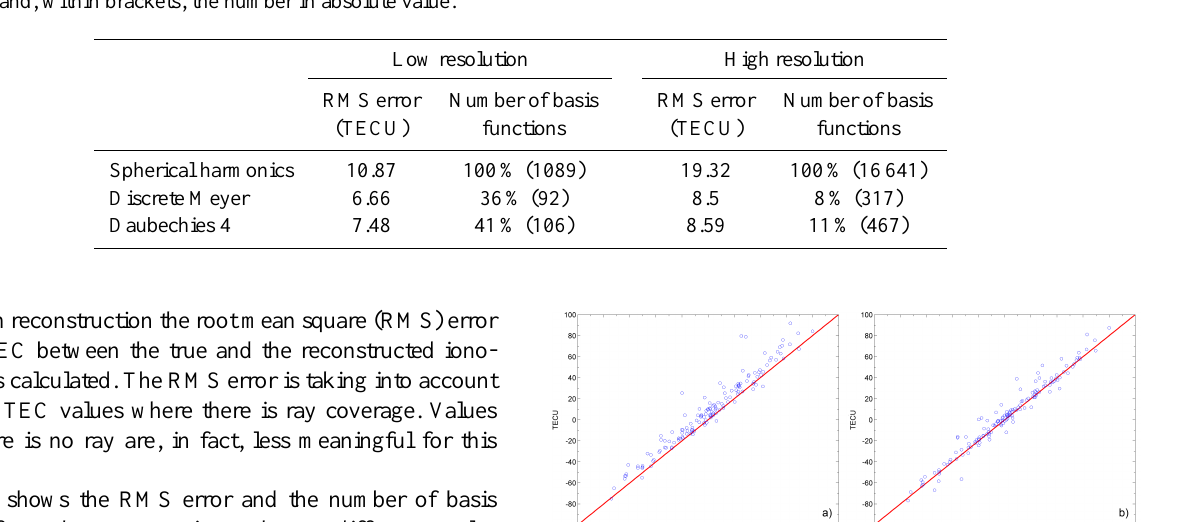
Table 1. RMS error (values are in TECU) of the VTEC map obtained with spherical harmonics and wavelets at two different resolutions. Only the VTEC coefficients where there is ray coverage were considered. The percentage of basis functions with non-zero coefficients is also shown and, within brackets, the number in absolute value.